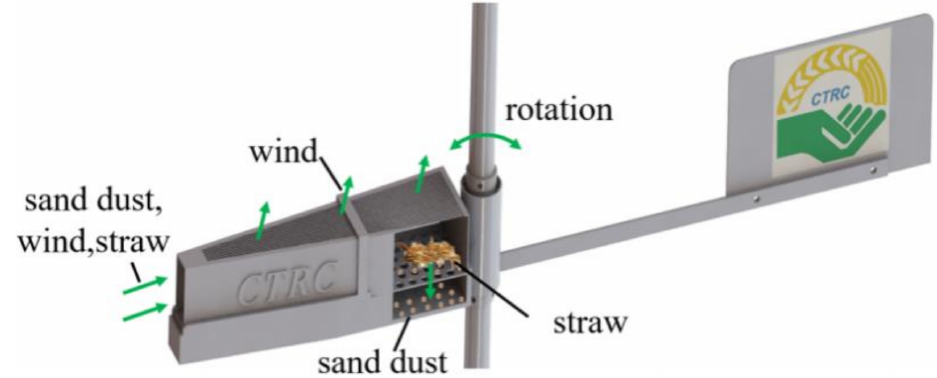
Figure 3. Schematic diagram of wind erosion